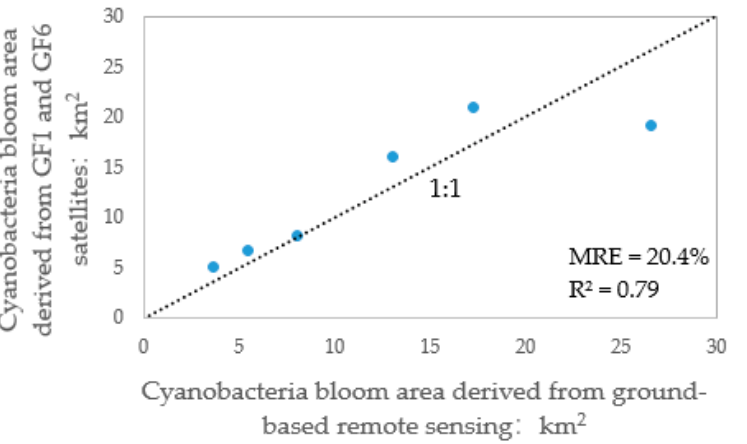
Figure 5. Comparison of the extraction results of cyanobacteria bloom from ground-based remote- sensing data and synchronous GF1-WFV and GF6-WFV data.